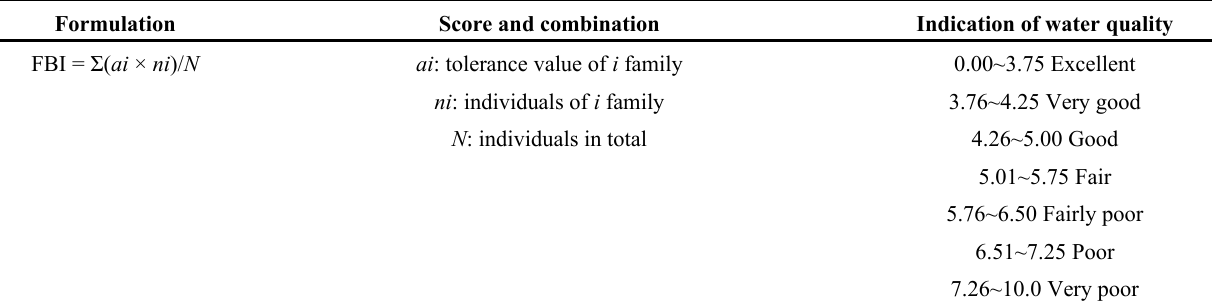
Table A3. The formulation of FBI, BI and IBI, indication of water quality. Formulation Score and combination Indication of water